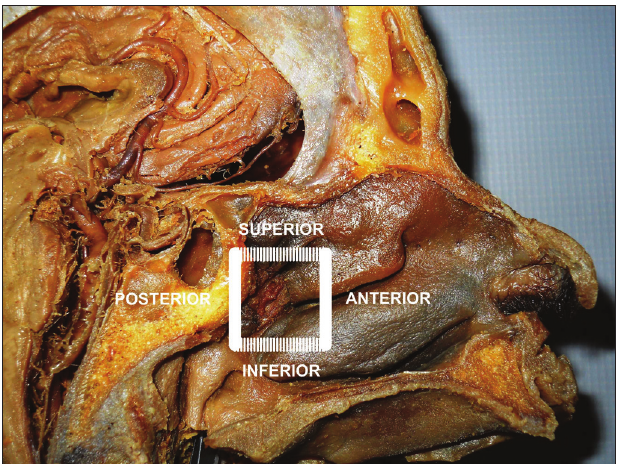
Figura 3. Fotografia de crânio em corte sagital com exposição da fossa nasal esquerda e da artéria esfenopalatina ipsilateral. O conhecimento